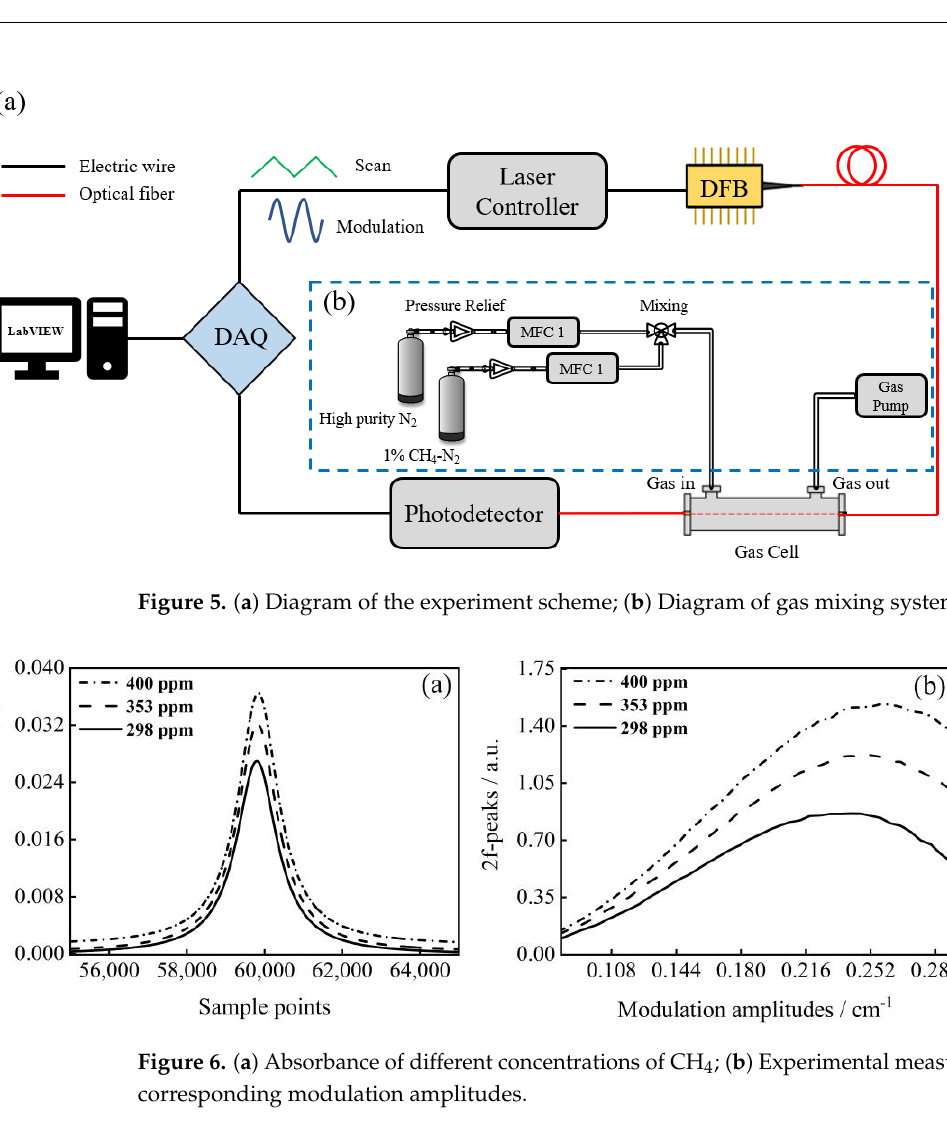
Figure 6. ( a ) Absorbance of different concentrations of CH 4 ; ( b ) Experimental measured 2f-peaks and corresponding modulation amplitudes.